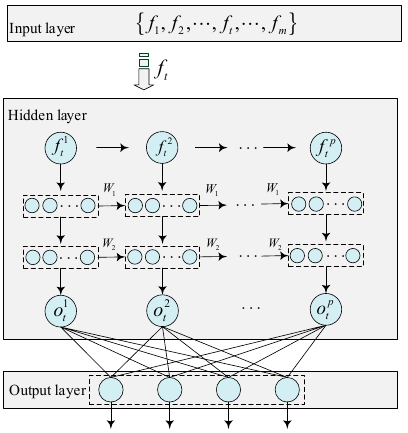
Figure 5. The process of depth determination based on GRU.